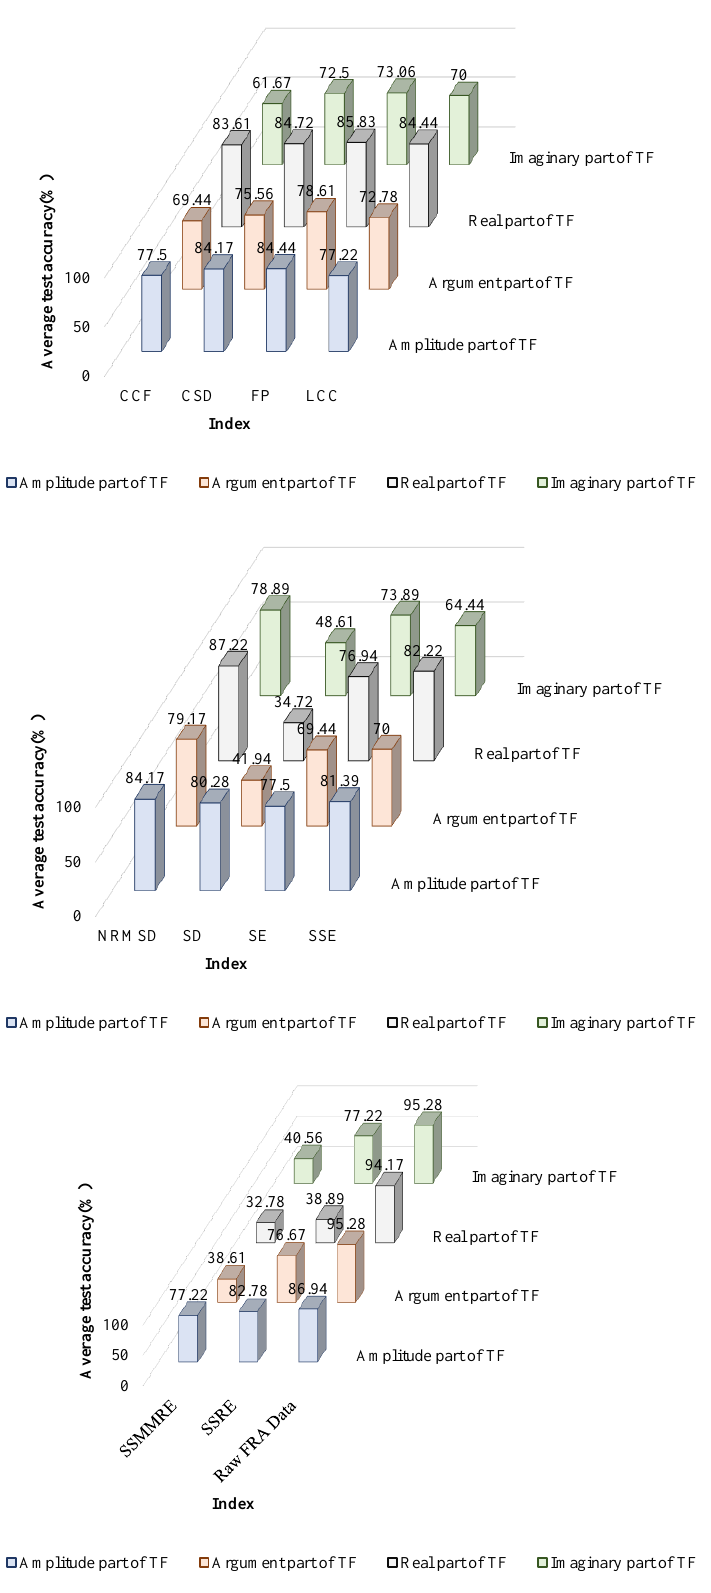
Figure 8. Evaluating the performance of the GMDH model in determining the DSV fault location using direct data of FRA and the extracted features by statistical indices.